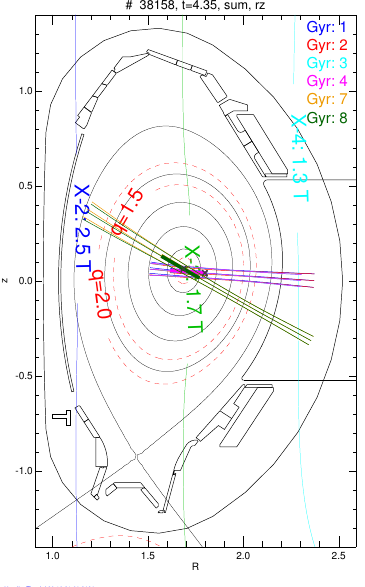
Figure 2. Initial setup for the EC system (poloidal projection): Beams 1-4 (horizontal) were tuned to 105 GHz, while beams 7,8, tuned to 140 GHz, target the thermo-couples on the upper HFS reflector tiles. B t = − 1 . 7 T . The solidly colored areas along the beam path indicate where the majority of the power is deposited as calculated by TORBEAM. The cold resonances shown as blue and green lines correspond to 140 GHz. Note that in the later discharges (#39747-39751), beam 7 was replaced by beam